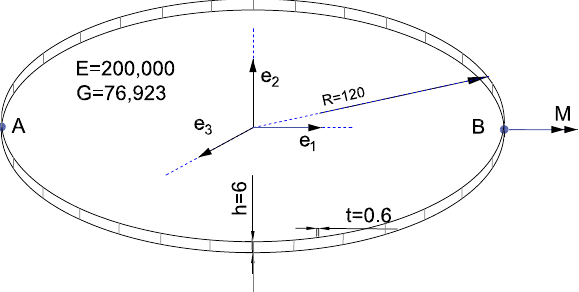
Figure 5. Ring: geometry, load, and boundary conditions.